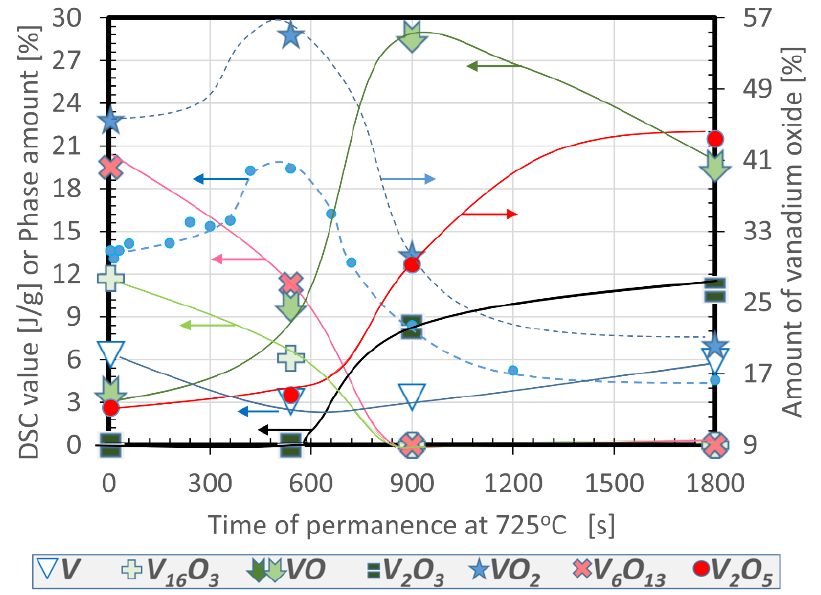
Figure 2. Latent heat (blue dots) and proportions of phases after V oxidations carried out at 725 °C at different times of exposure.